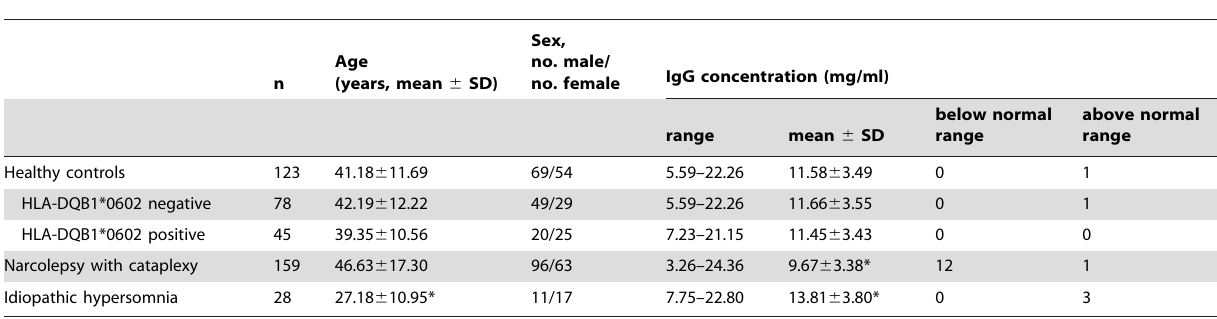
Table 1. Profile of the subjects.